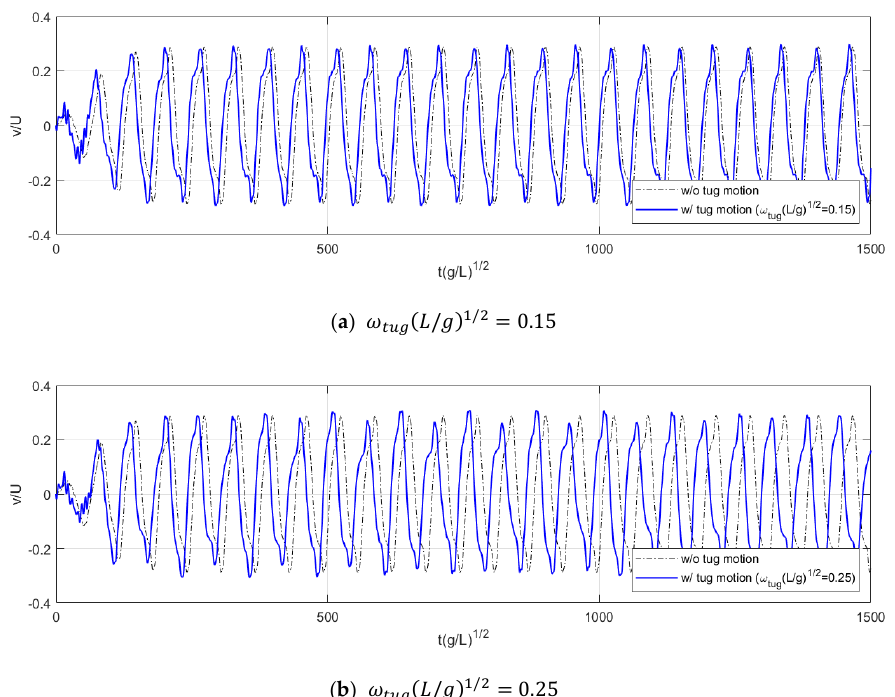
Figure 11. Time series of the towed vessel motion with tug longitudinal motions ( A tug / L = 0.05).